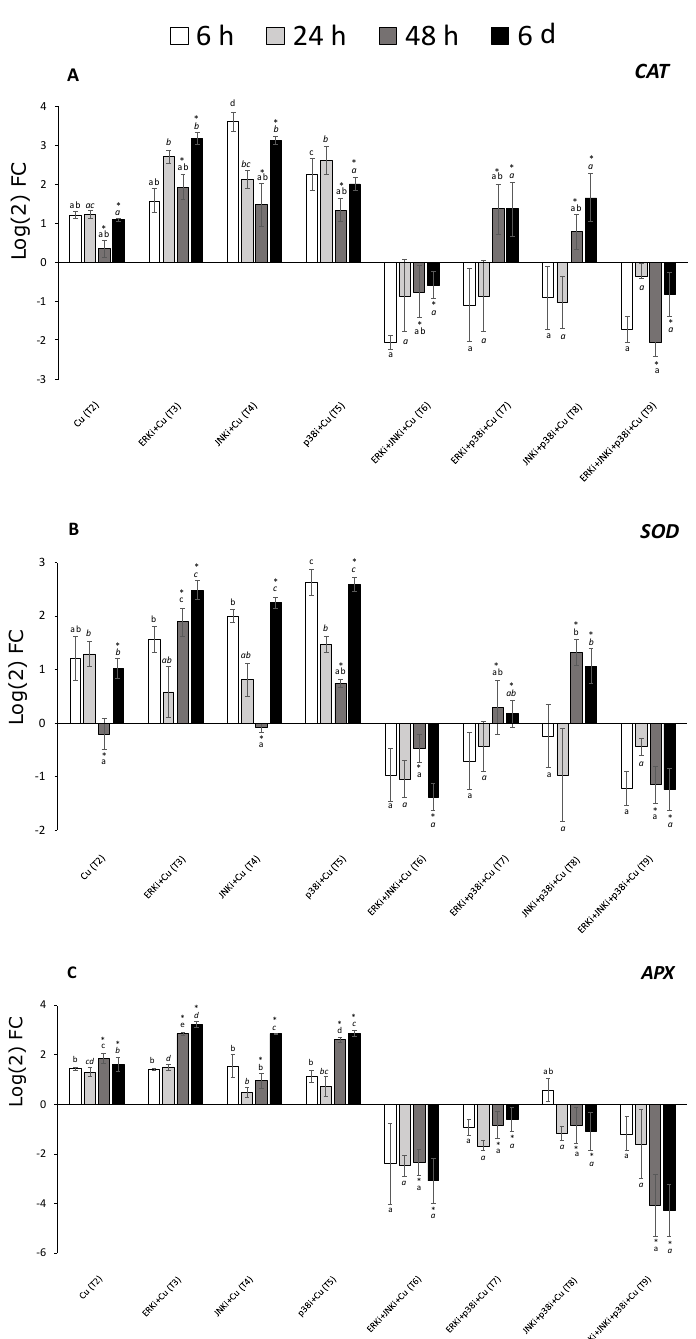
Figure 5. Relative expression of the genes catalase ( CAT ; A), superoxide dismutase ( SOD ; B), dehydroascorbate reductase ( DHAR ; C) in U. compressa under copper and/or exposure to MAPK inhibitors. Expression was relative to the levels of transcripts in U. compressa under control conditions. Treatments consisted in: T1) solely copper exposure as 10 µM of CuSO 4 (Cu); T2) copper + 5 µM MAPK ERK inhibitor PD98059 (Cu + ERKi); T3) copper + 5 µM MAPK JNK inhibitor SP600125 (Cu + JNKi); T4) copper + MAPK p38 inhibitor SB203580 (Cu + p38i); T5) Cu + ERKi + JNKi; T6) Cu + ERKi + p38i; T7) Cu + p38i + JNKi; and T8) Cu + ERKi + JNKi + p38i. Samples were analysed after 6 h ( A ), 24 h ( B ), 48 h ( C ), and 6 d ( D ) treatments. Different letters, in italics and/or with asterisk represent significant difference at 95% confidence interval ( p < 0.05) within each experimental time. Plots are represented as mean ± SE ( n = 3).